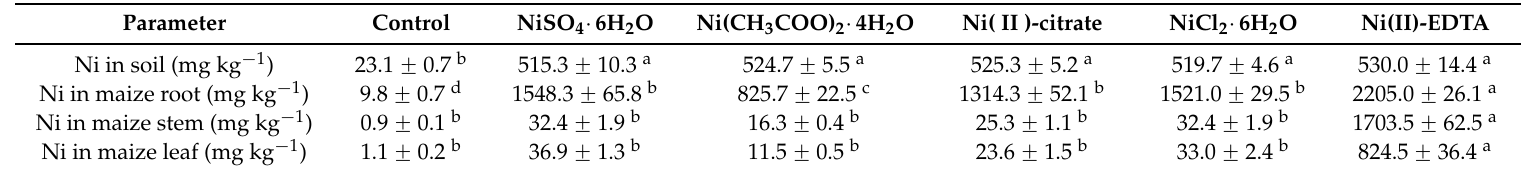
Table 2. Ni contents of maize roots, stems, and leaves after 28 days of exposure to different Ni compounds (560 mg Ni ¨ kg ´ 1 of soil) in